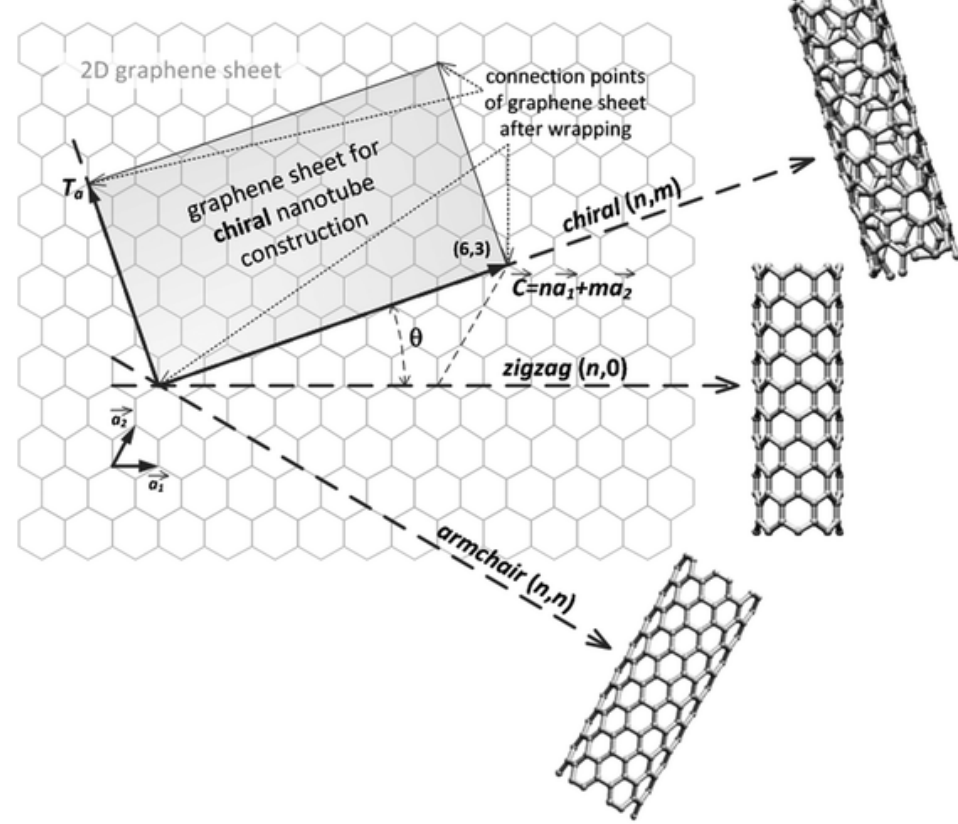
Figure 1. Schematic of SWCNTs rolled from graphene sheets using different chiral angles, Reproduced with permission from Royal Society of Chemistry [9].